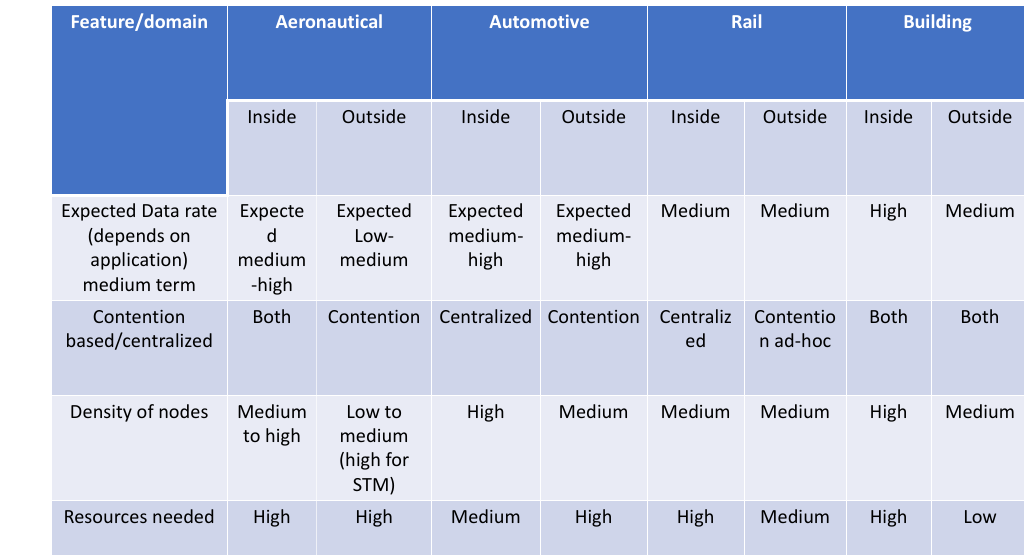
Figure 7. MAC-Layer features of DEWI Industrial domains.